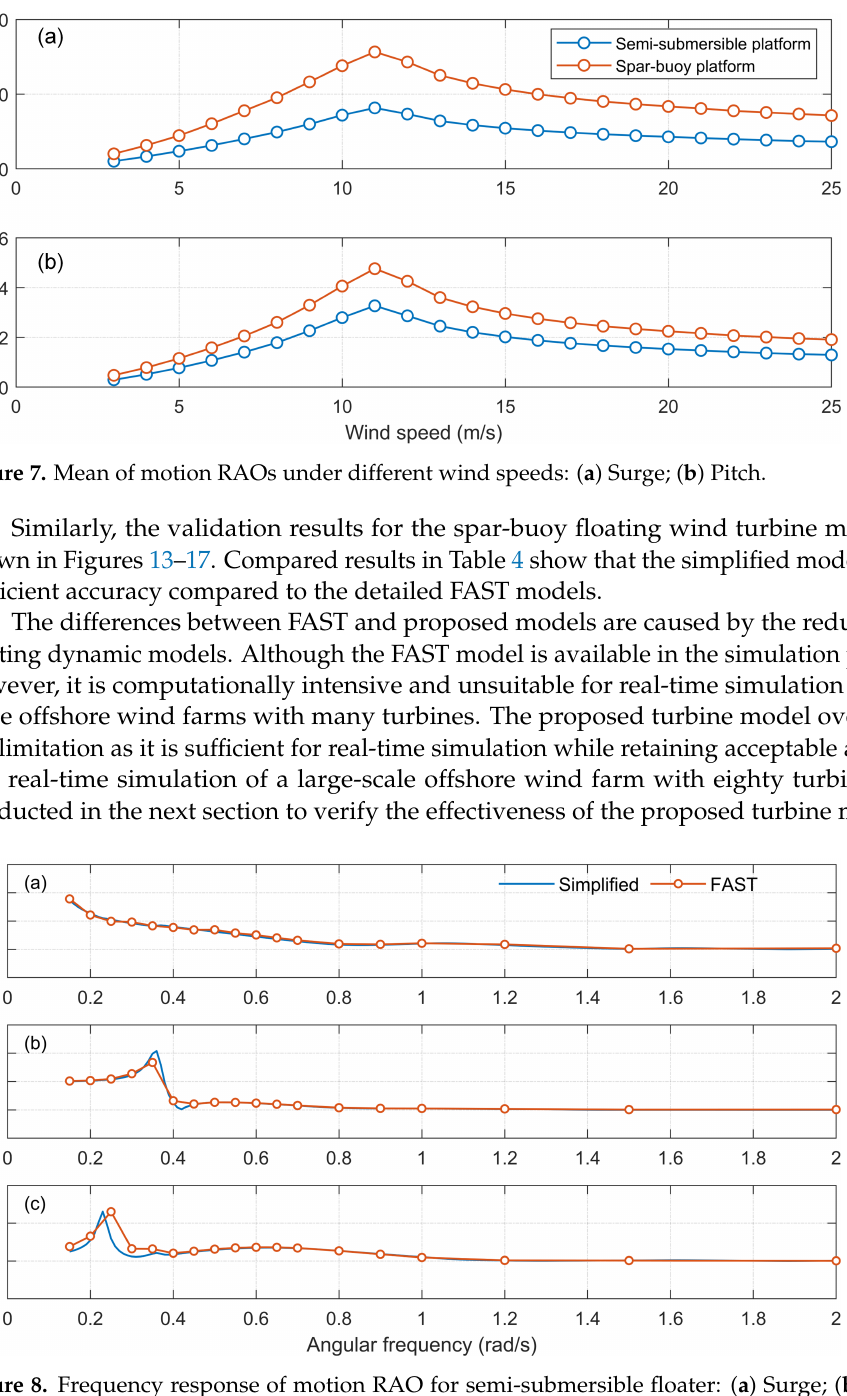
Figure 8. Frequency response of motion RAO for semi-submersible floater: ( a ) Surge; ( b ) Heave; ( c )